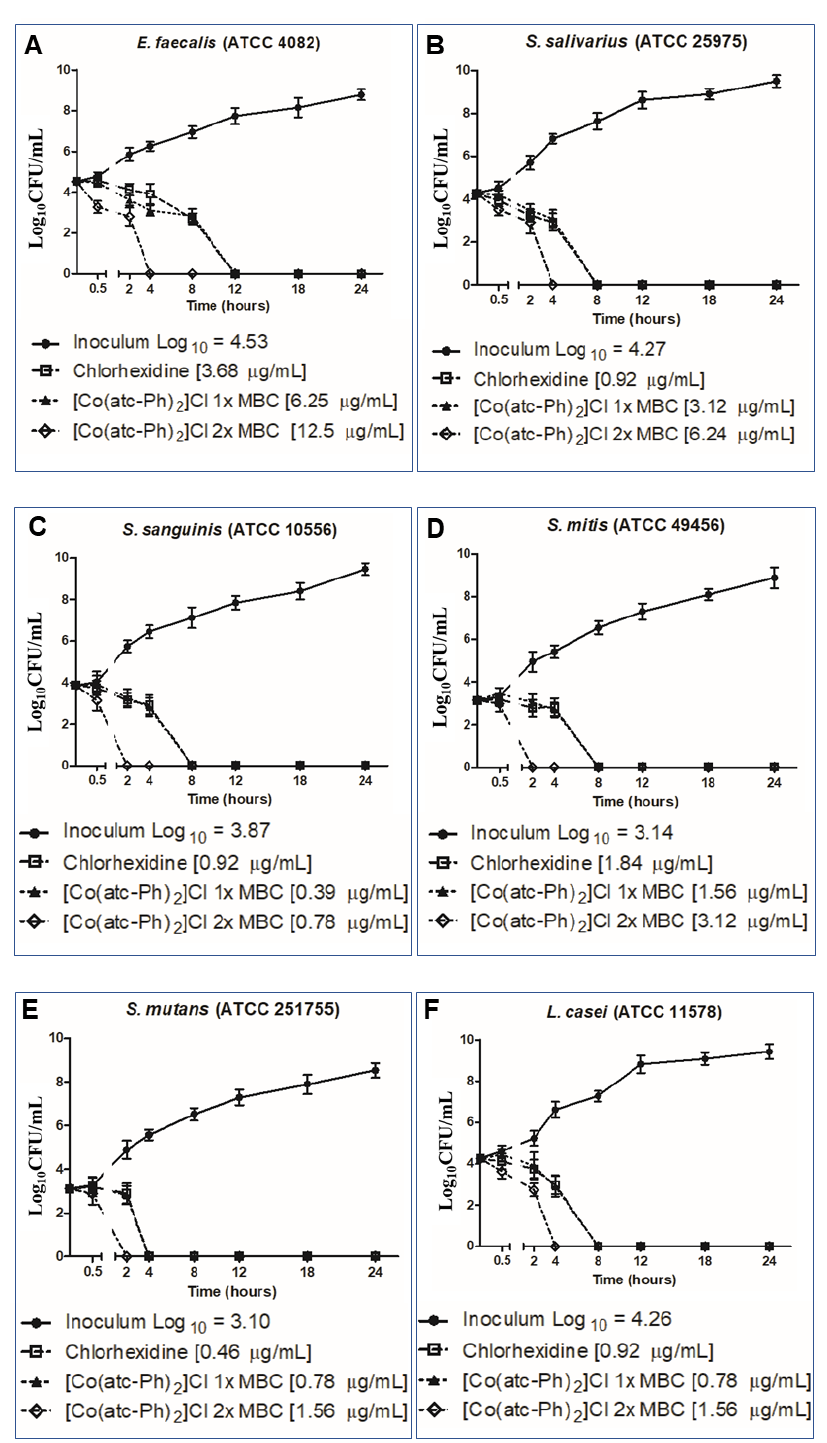
Figure 3. Time – kill curve profiles for complex 2 for caries bacteria as an antibacterial agent in different concentrations of MBC results, ( A ) E. faecalis ; ( B ) S. salivarius ; ( C ) S. sanguinis ; ( D ) S. mitis ; ( E ) S. mutans ; ( F ) L. paracasei .